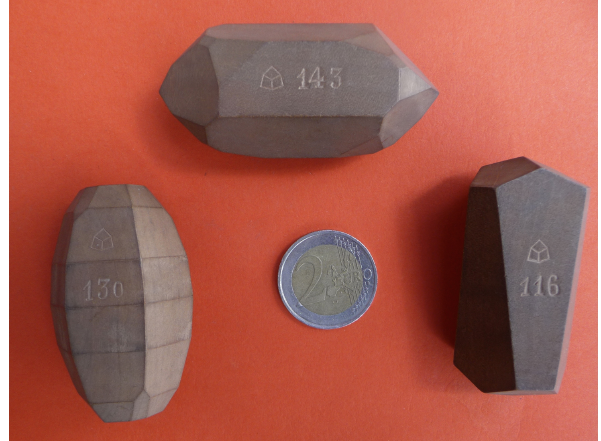
Figure 4. Logo of the Krantz company that can be read on three wooden models (numbers 116, 130, 145) of the École des Mines de Saint-Étienne